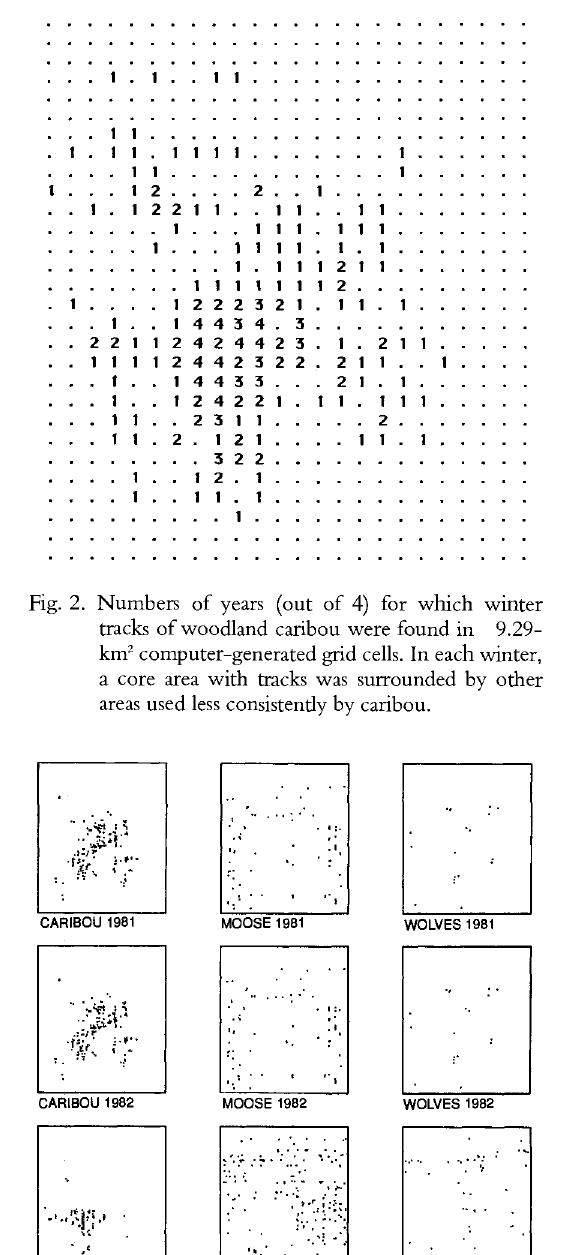
Table 1. Annually repeated occupation of same 9.29 km